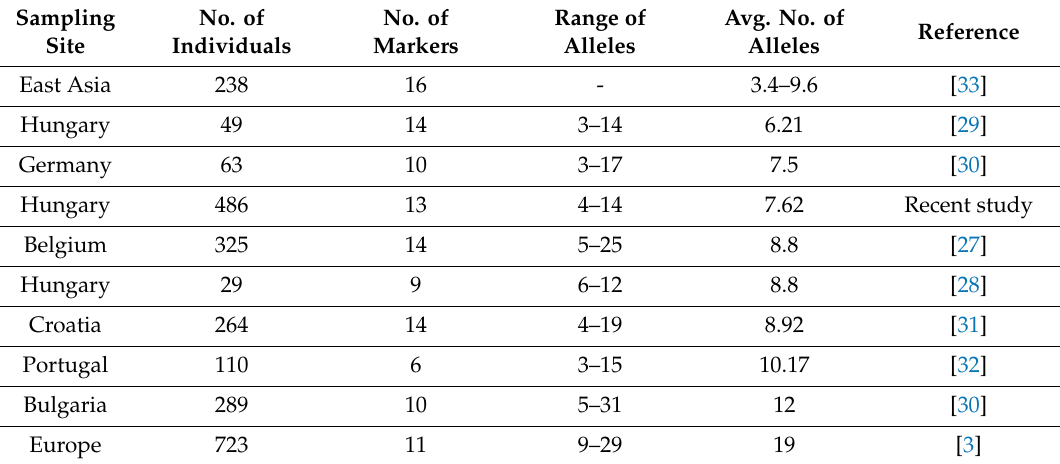
Table 3. Review table of recent studies sorted by average number of